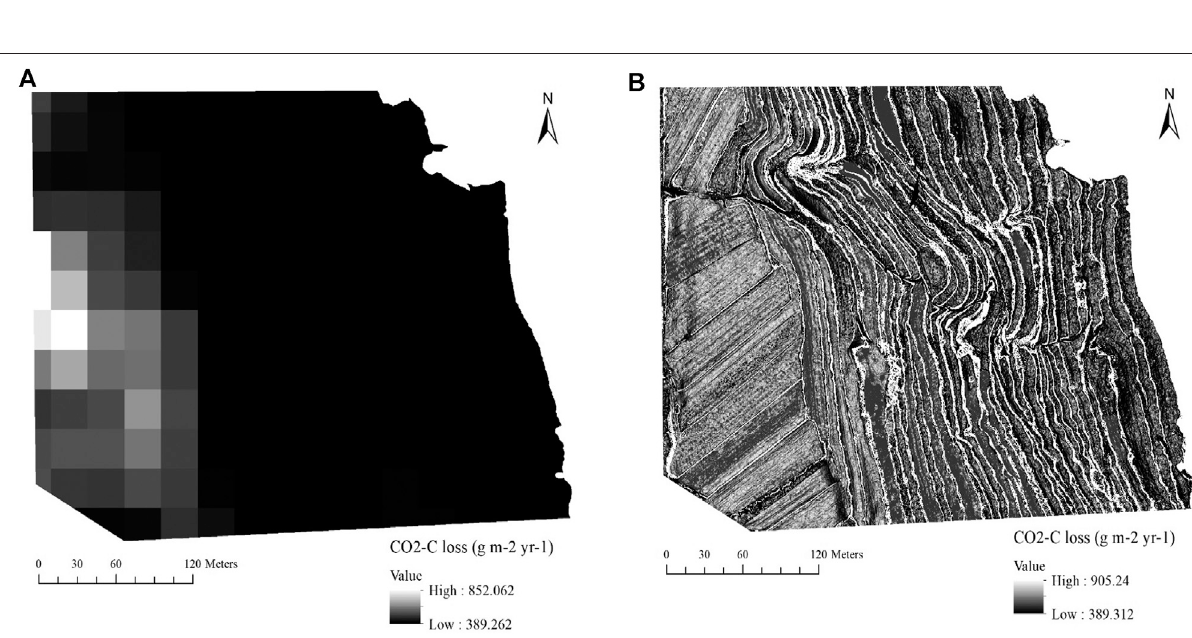
Frontiers in Environmental Science |